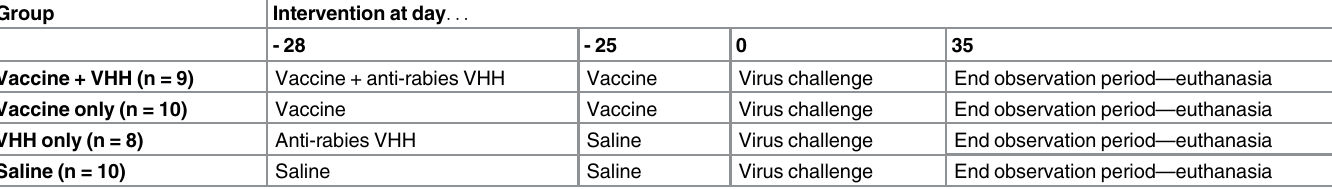
Table 1. Set-up of the pre-exposure vaccination experiment and interventions in different treatment groups. Group Intervention at day